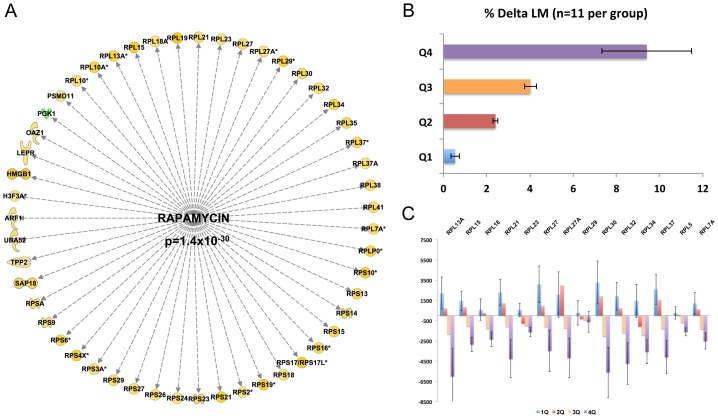
Inhibition of the mTOR-related expression network is correlated with gains in lean mass following RET.A) Quantitative SAM analysis was used to relate the change in RNA expression in response to 10 wk RET in 44 subjects. The change in gene expression was related to the change in lean mass (%) and a false discovery rate calculated based on permutation of the subject labels. Data were imported into IPA and 384 genes (FDR<5%) could be mapped to the data-base for up-stream analysis. An active rapamycin signature, equating to inhibition of mTOR signaling was discovered (Z-score = 2.8 for directional consistency; P-value for transcript overlap p = 1.4×10−30). B) Given the strength of the negative statistical association between the rapamycin signature, we then plotted the data to establish the precise nature of the relationship. We presented the mean gains in lean mass by quartiles establishing that 25% of the subject demonstrated negligible changes in lean mass. C) We selected a representative subset of the genes from Figure 2A and plotted the mean changes with respect to lean mass changes. This established that those with the greatest lean mass actually had a reduction in mTOR related genes with RET and not simple a lesser increase as one might have expected from first inspection of Figure 2A.